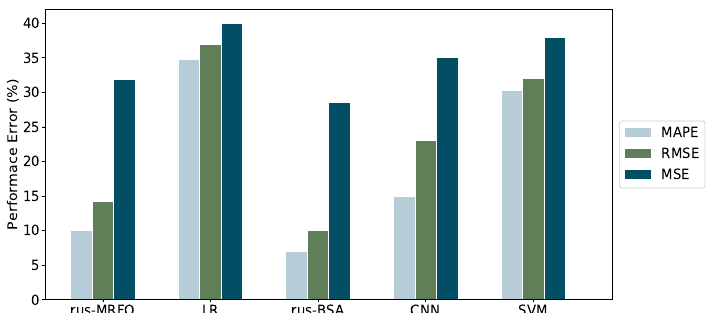
Figure 13. Overall performance